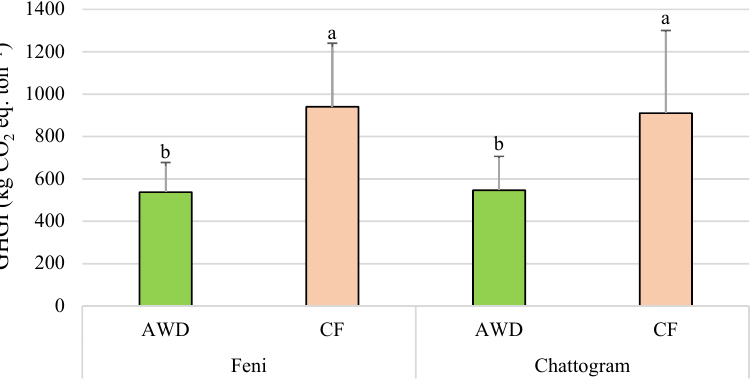
Figure 7. Effect of AWD and CF irrigation methods on the GHGI of paddy production in the Feni and Chattogram districts. Means with different letters indicate significant differences at the 5% level.